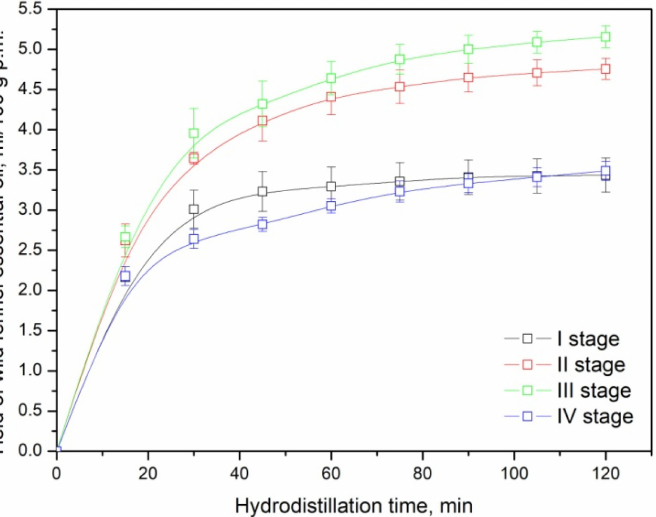
Figure 1. The yield of essential oil from wild fennel umbels with seeds (1st–4th stages of